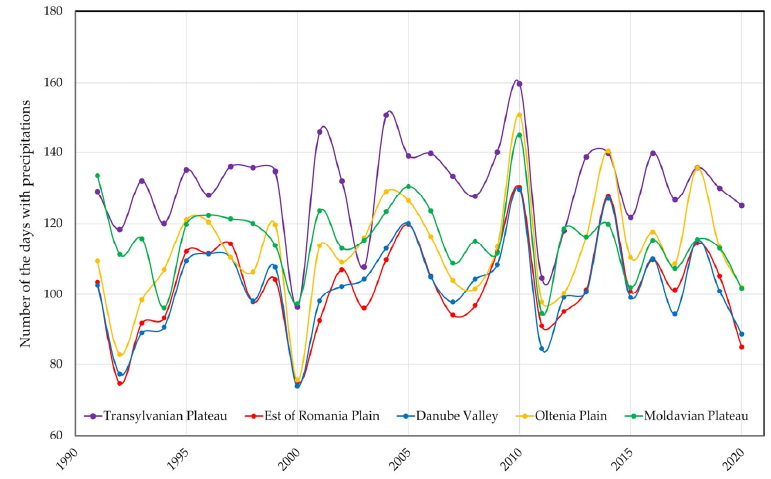
Figure 7. Days with precipitation in the period 1990–2020.